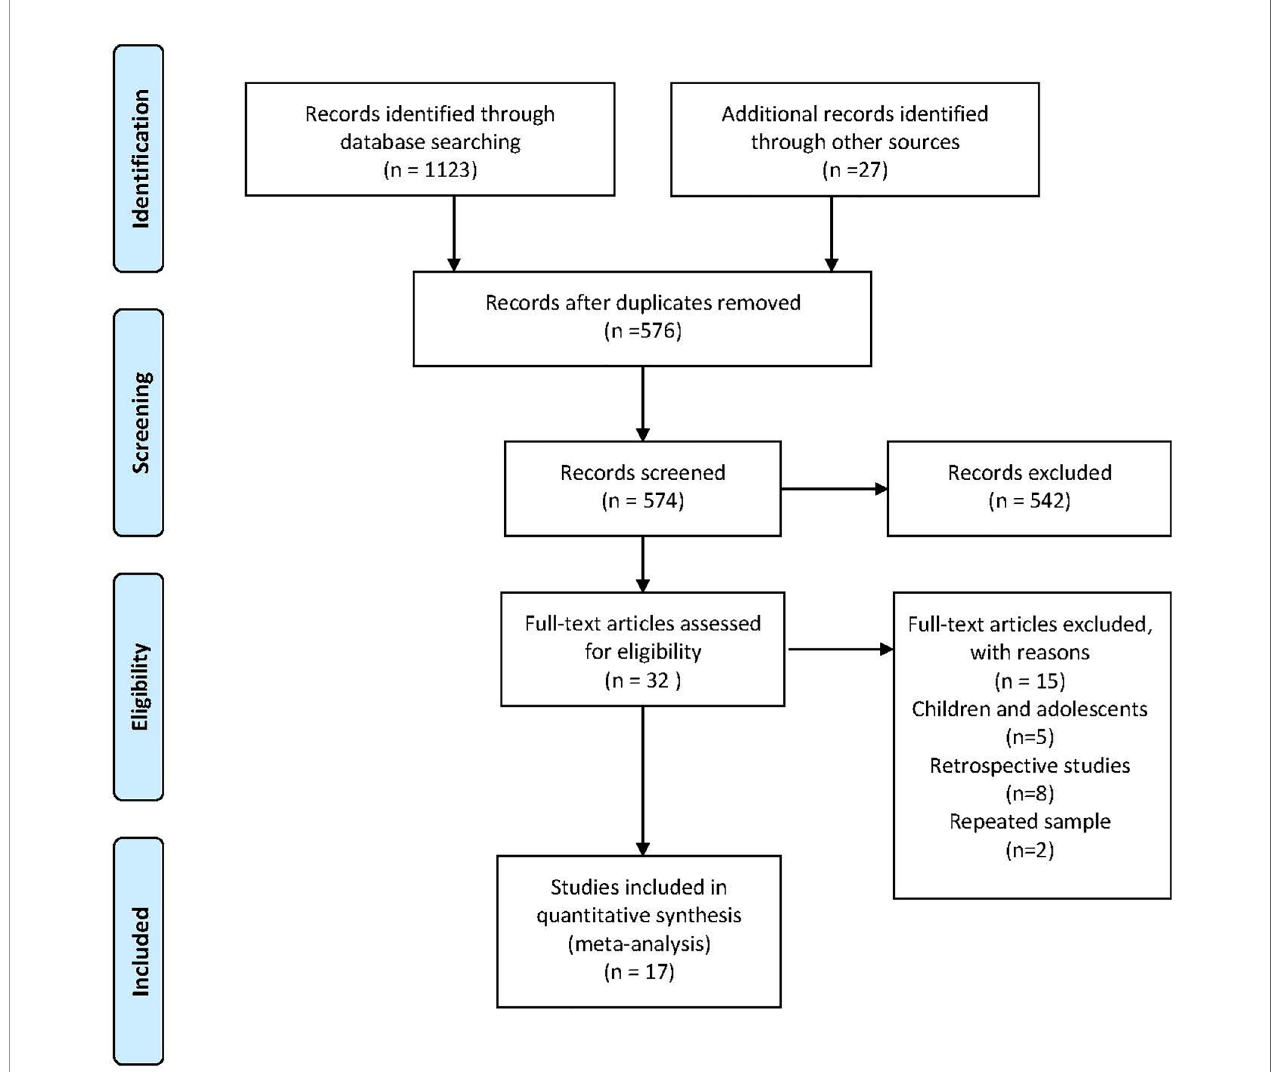
FIGURE 1 | Flowchart of the study selection